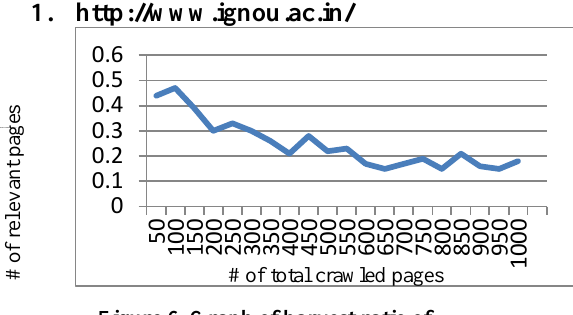
Figure 6. Graph of harvest ratio of